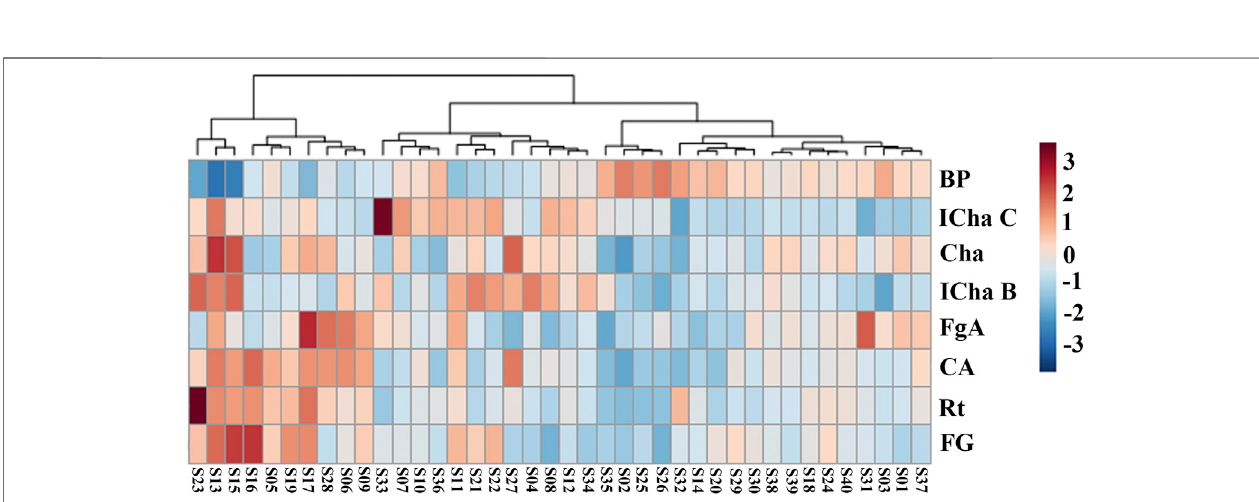
Frontiers in Pharmacology |